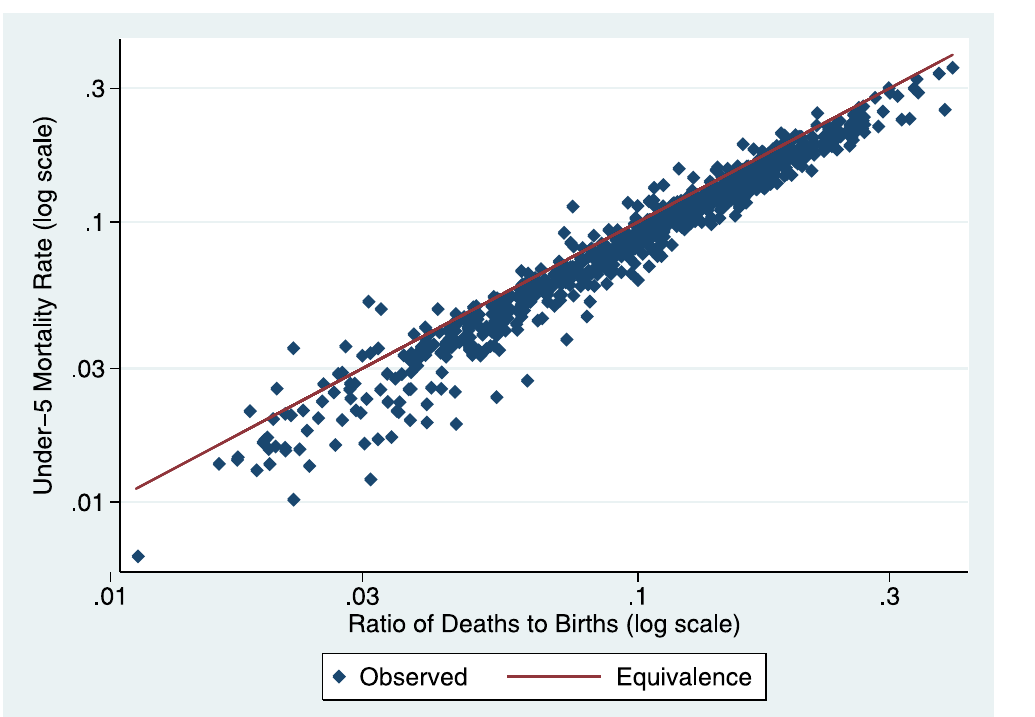
Fig 2. Relationship between ratios of cumulated cohort changes in CD to CEB and U5MR in DHS: One Year Period (log scale). This figure shows the relationship between annual estimates of U5MR and ratios of births to deaths for one- or two-year periods from 168 Demographic and Health Surveys.